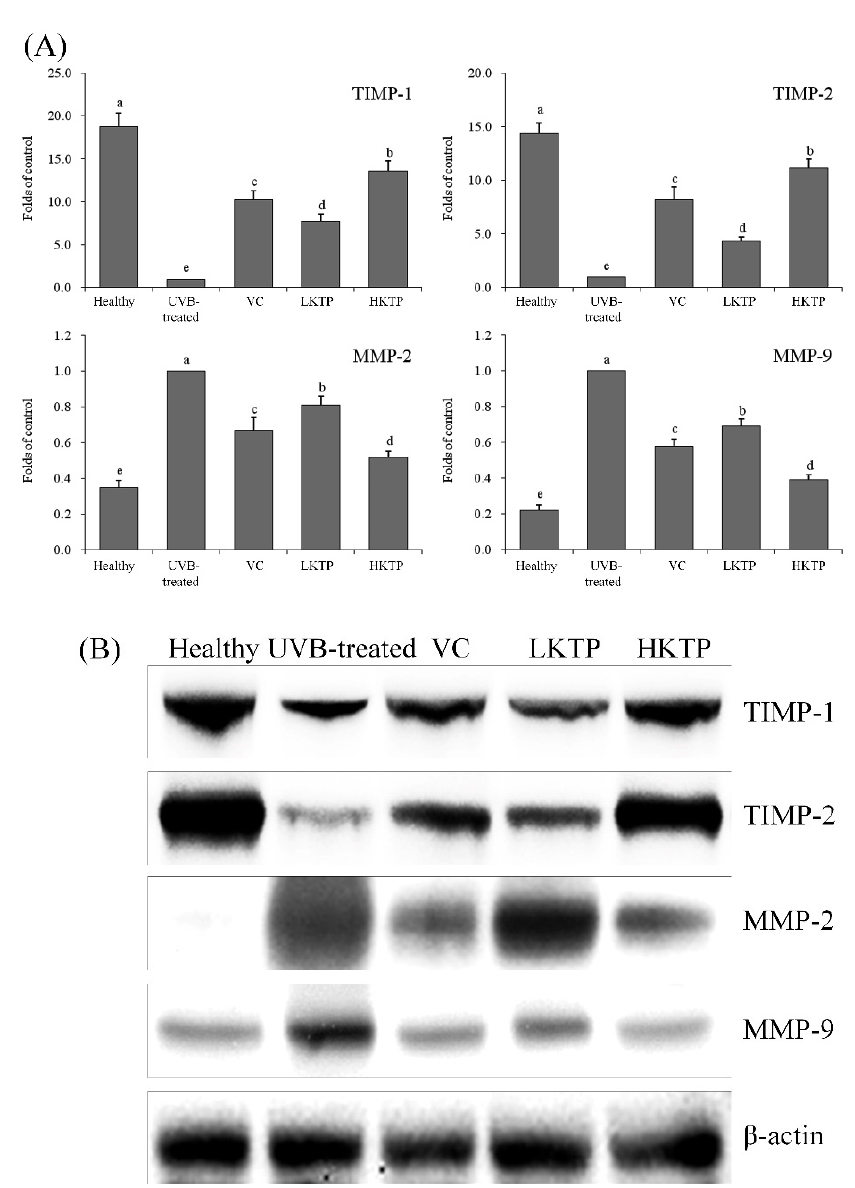
Figure 4. TIMP-1, TIMP-2, MMP-2, and MMP-9 mRNA ( A ) and protein ( B ) expression in skin tissue of SKH1 hairless mice with UVB-induced skin aging. Values presented are the means ± standard deviation (N = 10/group). a–e Mean values with different letters in the same bars are significantly different ( p < 0.05) according to Duncan’s new MRT. VC: mice were smeared with 5.0% VC solution; LKTP: mice were smeared with 2.5% polyphenols of Kuding tea; and HKTP: mice were smeared with 5.0% polyphenols of Kuding tea.